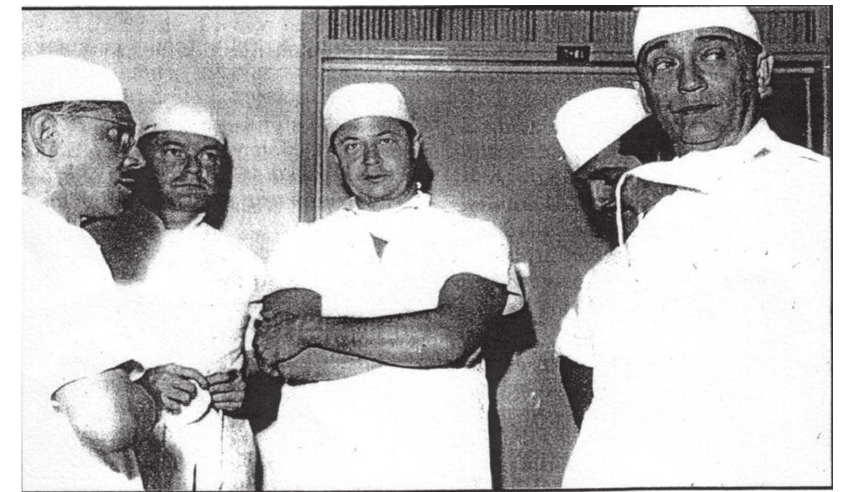
Fig. 1 - Registro da 1ª cirurgia cardíaca extracorpórea no Rio de Janeiro. Entre os presentes: Drs. José Hilário, Henry A Zimmerman, Earl B. Kay, Cid Nogueira e o presidente do Brasil, o Dr. Juscelino Kubitschek de Oliveira, que também era médico.